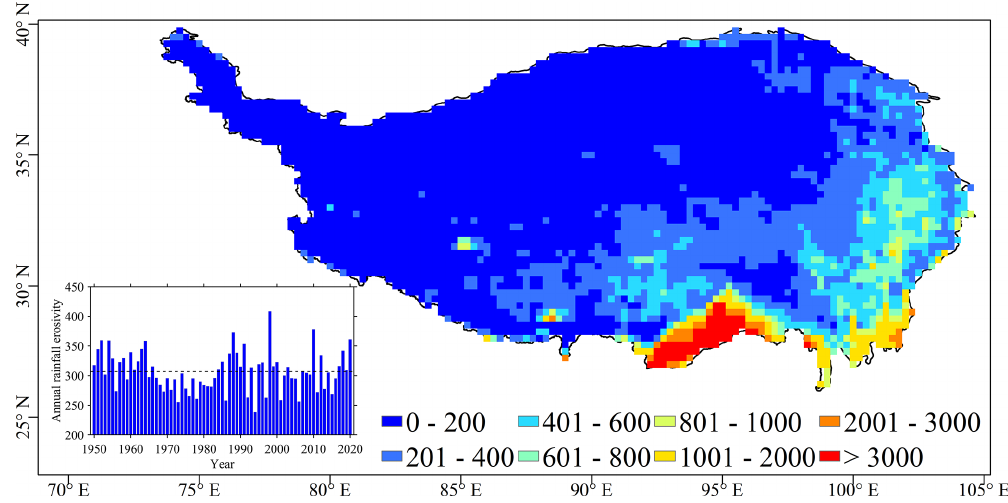
Figure 11. R factor map of TP with the 0.25 ◦ spatial resolution for 1950–2020. The inset represents the yearly change in annual rainfall